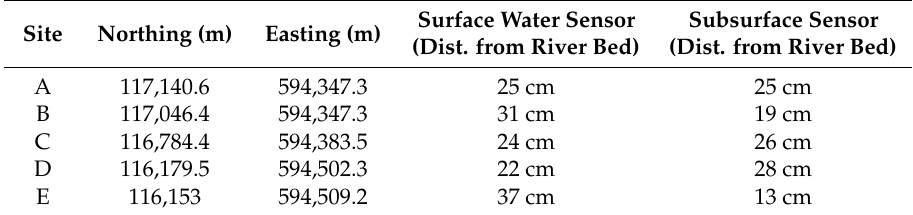
Table 2. Coordinates (based on NAD 1983 StatePlane Washington South system) and depths of the iButton sensors installed at the monitoring